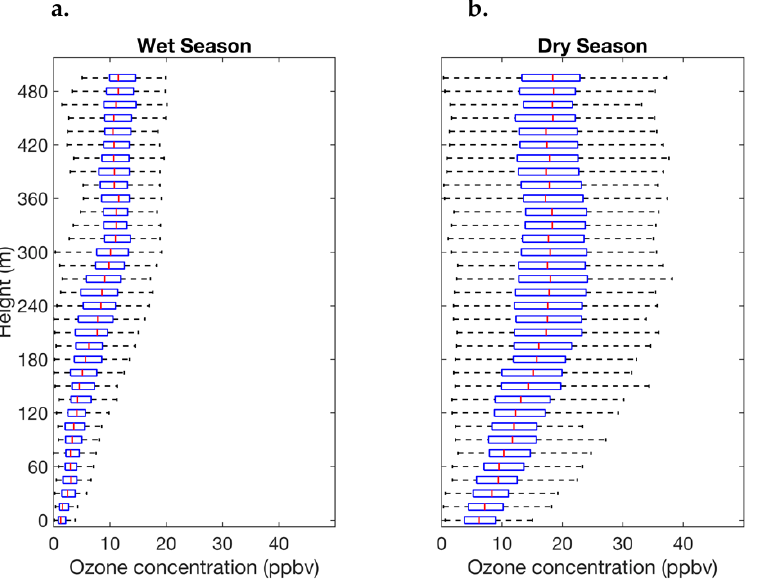
Figure 2. Box-whisker plots of the statistics of ozone concentration at different altitudes. Results are presented for the ( a ) wet and ( b ) dry seasons of 2018 (57 and 84 flights, respectively). The red line represents the median, the box edges show the quartiles, and the horizontal black lines indicate the minimum and maximum values, excluding outliers. Flights took place between 20:00 and 00:00 (local time (LT)). LT was 4 h earlier than UTC. The data of panel (a) are from Guimarães et al. [10].